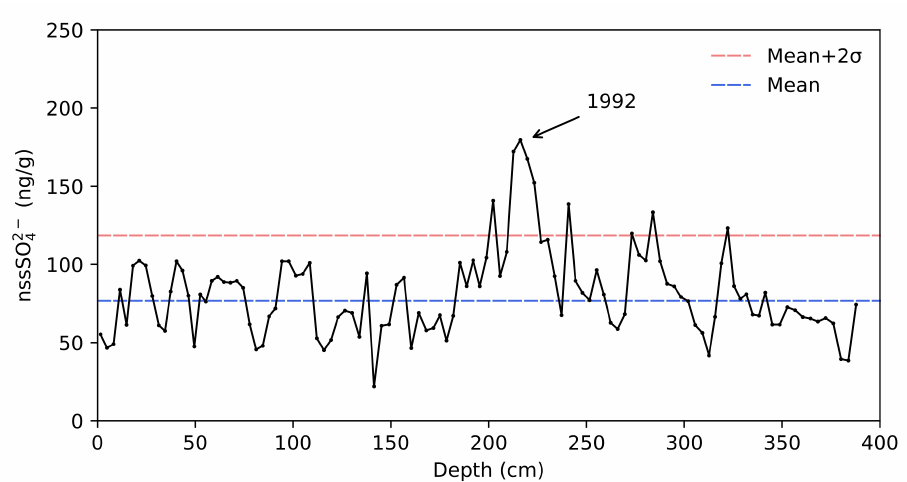
Figure 3. nss-sulphate concentration vs. depth profiles and dating of the Mount Pinatubo eruption. The dashed blue line represents the threshold for the biogenic background contribution to nssSO 42 − . The dashed red line shows the mean +2 σ for distinguishing the superimposed volcanic